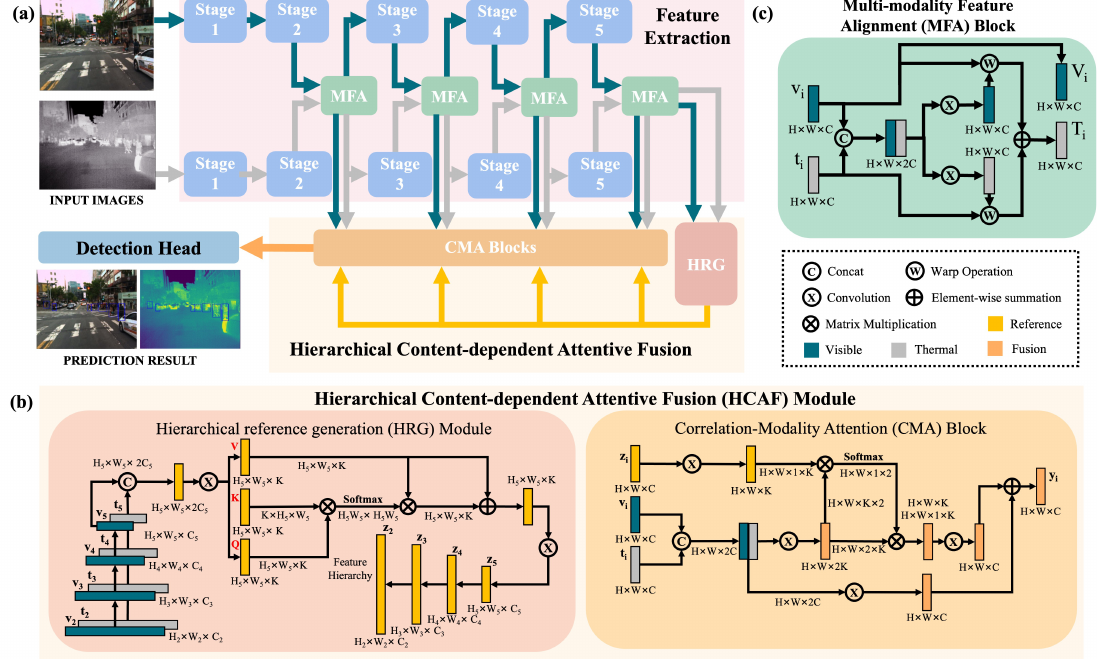
Figure 2. Architecture of the proposed HAFNet. The HAFNet consists of a feature extraction module plugged into a multi-modality feature alignment (MFA) block, a novel hierarchical content- dependent attentive fusion (HCAF) module, and a detection head module. ( a ) Workflow of the proposed HAFNet. ( b ) Workflow of the proposed HCAF module, which comprises a Hierarchical reference generation (HRG) module and correlation-modality attention (CMA) block. ( c ) Workflow of the MFA